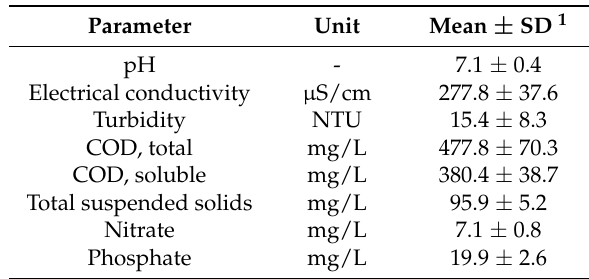
Table 1. Physicochemical characterization of the influent synthetic